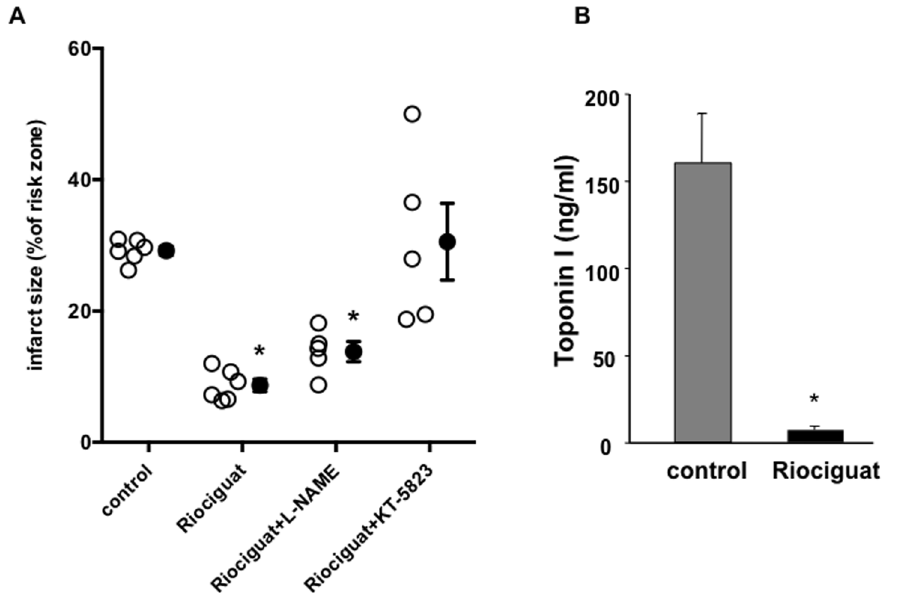
Figure 1. Effects of riociguat on infarct size after acute myocardial infarction. ( A ) Riociguat reduced infarct size significantly when given just before the onset of reperfusion after 30 min ischaemia in an acute in vivo mouse model. The protection was unaffected by the NOS inhibitor L- NAME, but blunted when the PKG inhibitor KT5823 was administered prior to riociguat. Open symbols represent individual experiments and closed symbols are means 6 SEM. ( B ) Troponin I level in blood serum taken at the end of the 120 min reperfusion further support the results of the histological measurements. * p , 0.001.